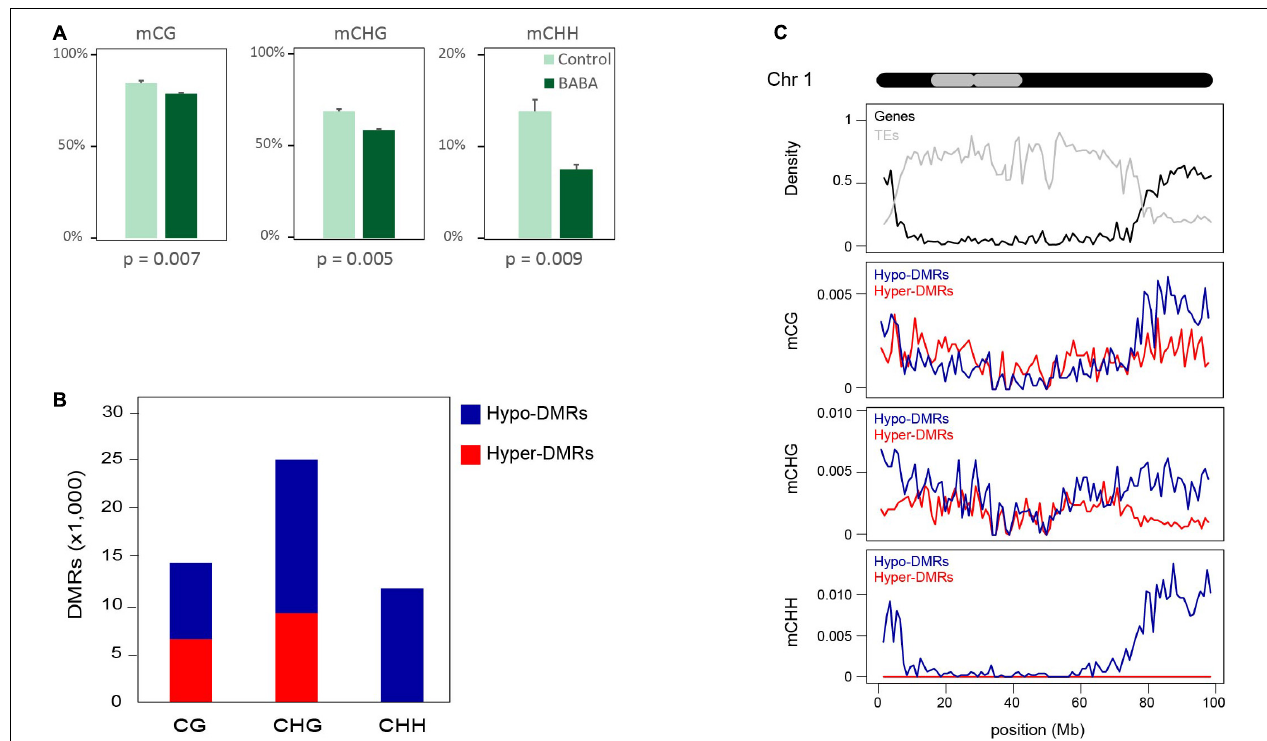
FIGURE 1 | Global changes in DNA methylation patterns in response to BABA priming. (A) Global methylation levels (% of total cytosine bases) in control and BABA-primed plants. (B) Numbers (thousands) of DMRs in each cytosine context with increased (Hyper-DMRs) or decreased (Hypo-DMRs) methylation in BABA treated plants compared to controls. (C) Density of differentially methylated regions across chromosome 1 in each context (mCG, mCHG, and mCHH) separated into regions gaining (Hyper-DMRs; red lines) or losing (Hypo-DMRs; blue lines) methylation after BABA treatment. The chromosome structure is displayed in black at the top with the grey area marking heterochromatic regions (Zhong et al., 1998). Gene (black line) and TE (grey line) densities are displayed in the top track. Density was computed in a 1 Mb window along the